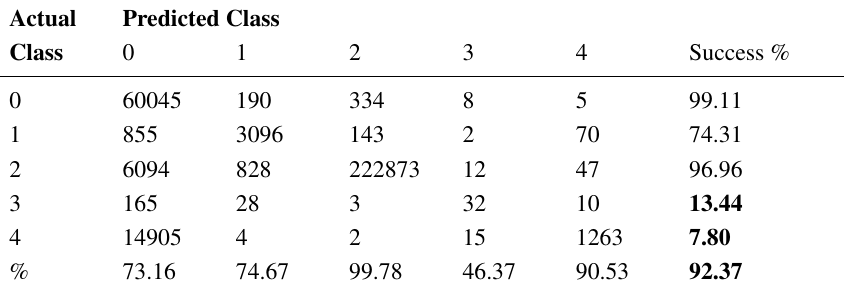
Table 3. Confusion matrix without incremental learning (Termination Condition 2).